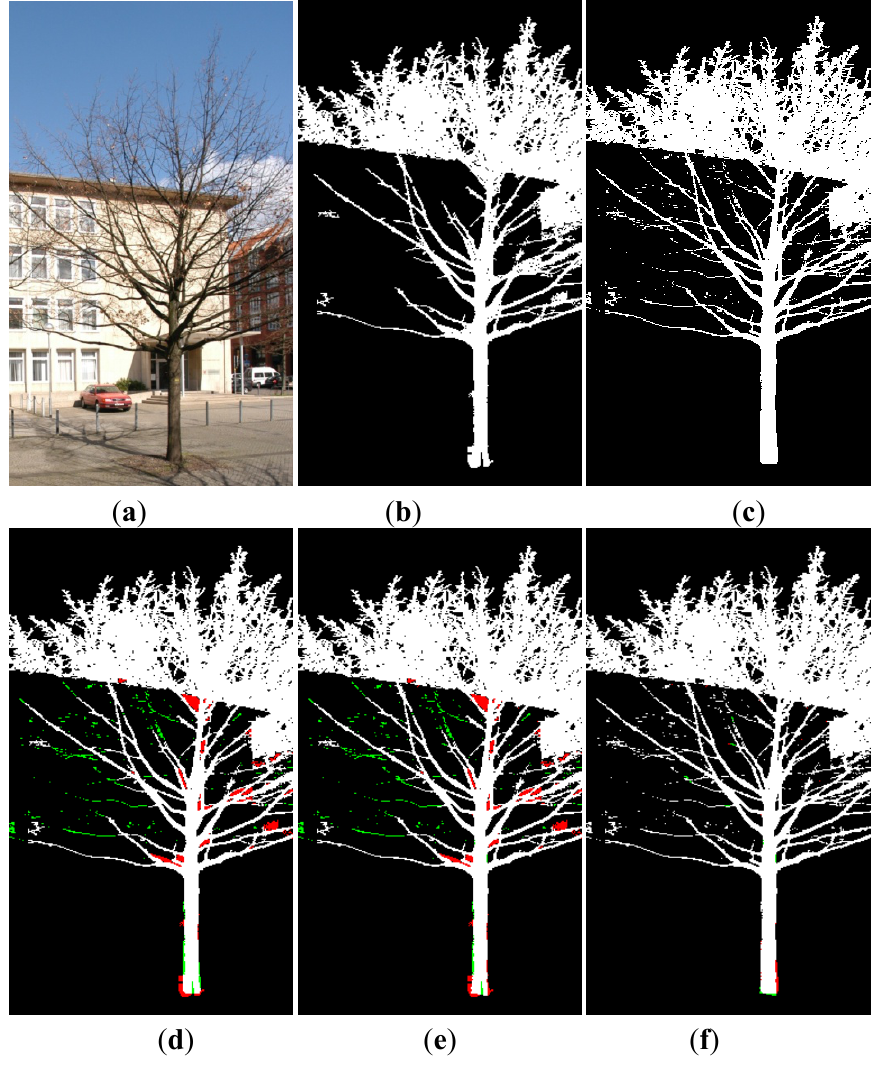
Figure 19. Demonstration of the graph-cut application: ( a ) Image of the studied tree. ( b ) The classified tree segment before applying the graph-cut refinement phase. ( c ) The classified tree segment following the graph-cut application. ( d ) Differences following the application of the refinement phase: in green added points, in red deleted points. ( e ) Difference between the ground truth and the classified tree segment, before the graph-cut application: in red type-I error (false alarm) and in green type-II error (miss). ( f ) Difference between the ground truth and the classified tree segment, following